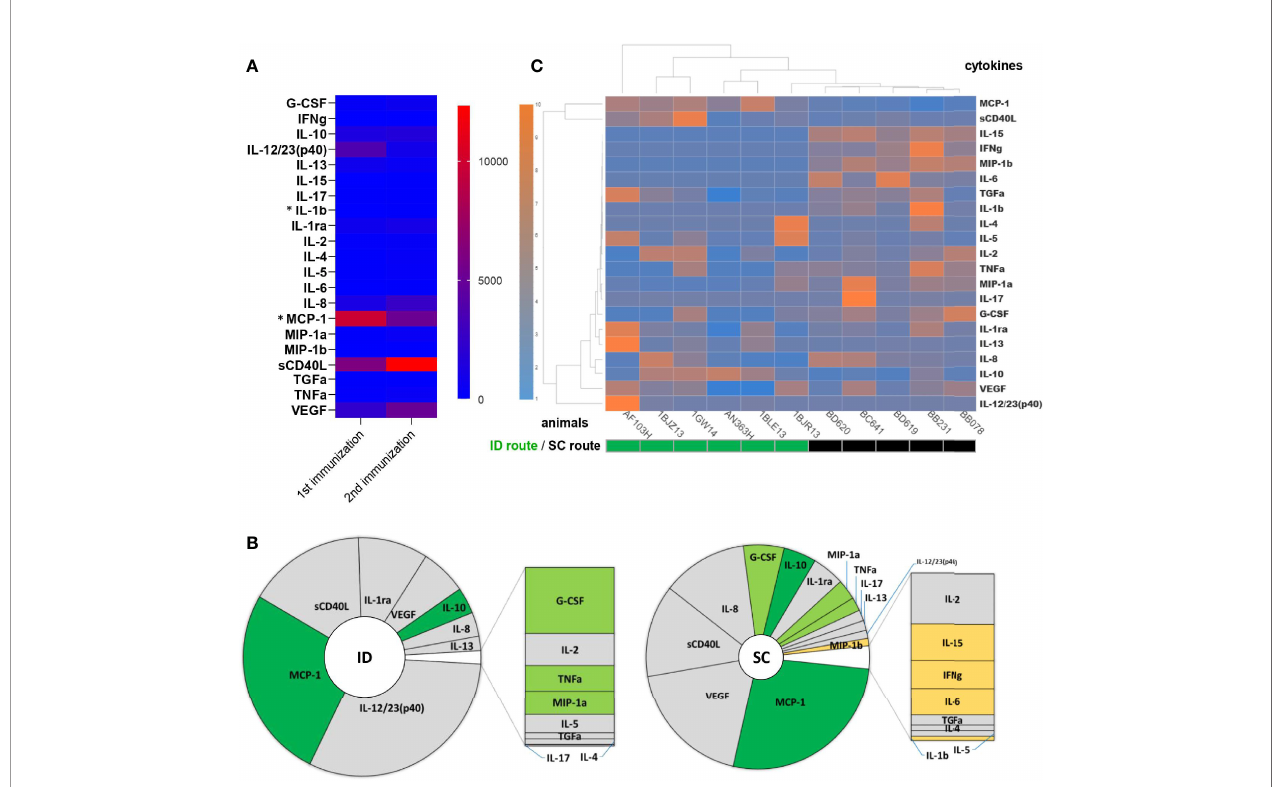
FIGURE 3 | Comparison of cytokine and chemokine expression pro fi les in blood after ID or SC MVA immunizations. The plasma concentration of 22 cytokines was measured before, 1 day, 7 days, and 14 days after MVA injected either ID (n = 6) or SC (n = 5). Areas under the curve from H0 to D14 post-immunization were calculated to represent an approximation of exposure over time, in pg×ml -1 ×day. (A) The mean AUC of each cytokine after the fi rst and second MVA ID injection is shown as a heatmap. Colors represent the AUC values from the lowest (blue) to the highest (red), standardized for each row. Statistically signi fi cant differences (p < 0.05, Wilcoxon tests) between the 1 st and 2 nd injection are indicated by an asterisk (*). (B) The mean AUC of each cytokine produced after the fi rst ID (left) or SC (right) MVA injection is displayed as a pie-chart. Differentially expressed cytokines according to the vaccine delivery route are colored in dark green for cytokines with a higher concentration after ID injection than SC, in light green for those with a higher concentration after SC injection than ID, and in yellow for those produced only after SC injection. The size of the inner pie is proportional to the sum of the AUC of all cytokines. (C) Heatmap representation of individual AUC for each cytokine after the fi rst ID or SC injection of MVA. Each row corresponds to a cytokine and each column to an animal. Dendrograms represent the hierarchal clustering of animals (upper) and cytokines (left) based on the Euclidean distance using the Ward2 clustering method. Colors represent the AUC values from the lowest (blue) to the highest (orange), standardized for each